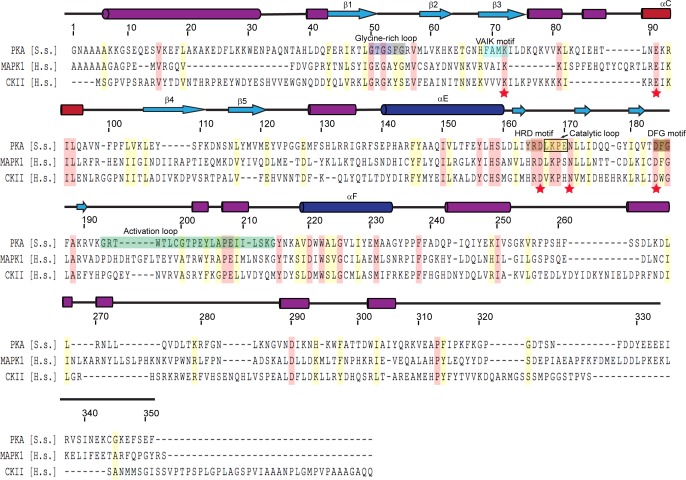
Multiple sequence alignment of representative protein kinases.The secondary structure of PKA is labeled above the sequence, and PKA residue numbers are marked on the top of the alignment. Identical residues are highlighted in red and similar residues in yellow. Kinase catalytic residues are marked with red stars and conserved kinase signature motifs are highlighted in a color scheme similar to that used for the SidJ kinase-like domain. Note that the catalytic loop in protein kinase contains only four amino acids, while the catalytic loop of SidJ is comprised of a large insertion (>40 amino acids, Figure 3—figure supplement 1). Accession numbers are as follows: cAMP-dependent protein kinase catalytic subunit alpha (PKA), Sus scrofa, P36887.4; mitogen-activated protein kinase (MAPK1), Homo sapiens, P28482; Casein kinase II subunit alpha (CKII), Homo sapiens, P68400.